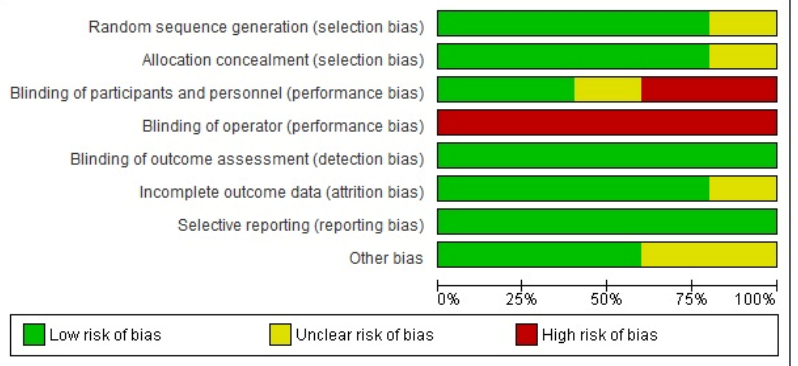
Figure 3. Individual RCT risk of bias across studies.